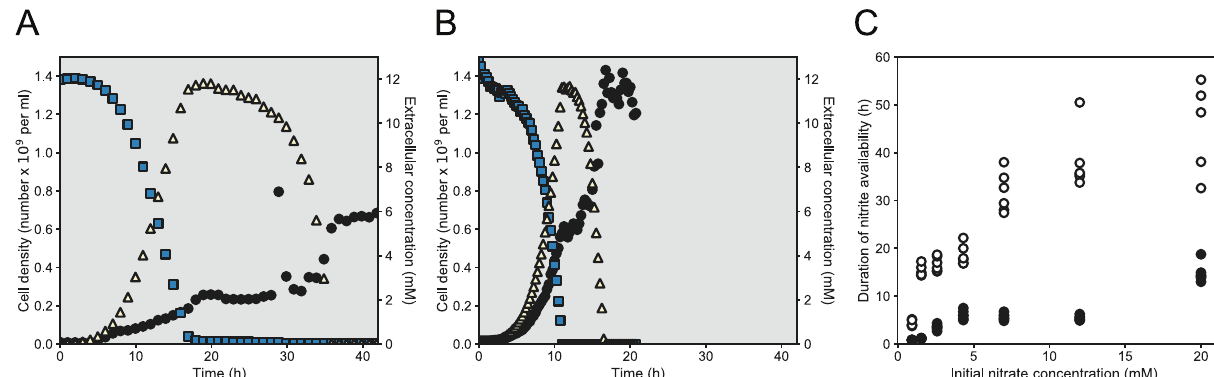
Fig. 3 Growth and nitrogen oxide dynamics of the generalist in batch culture. We grew the generalist alone in a bioreactor at A pH 7.5 (weak nitrite toxicity) or B pH 6.5 (strong nitrite toxicity) under anoxic conditions with nitrate as the growth-limiting substrate. Blue squares are measured extracellular nitrate concentrations, yellow triangles are measured extracellular nitrite concentrations, and black circles are measured cell densities. We measured extracellular nitrate and nitrite concentrations with IC and cell densities with FC. C Measured durations of nitrite availability for the generalist growing in batch culture. We grew the generalist alone in 96-well microtiter plates under anoxic conditions with nitrate as the growth-limiting substrate. Open symbols are durations of nitrite availability at pH 6.5 and closed symbols are durations of nitrite availability at pH 7.5. Each symbol is an independent biological